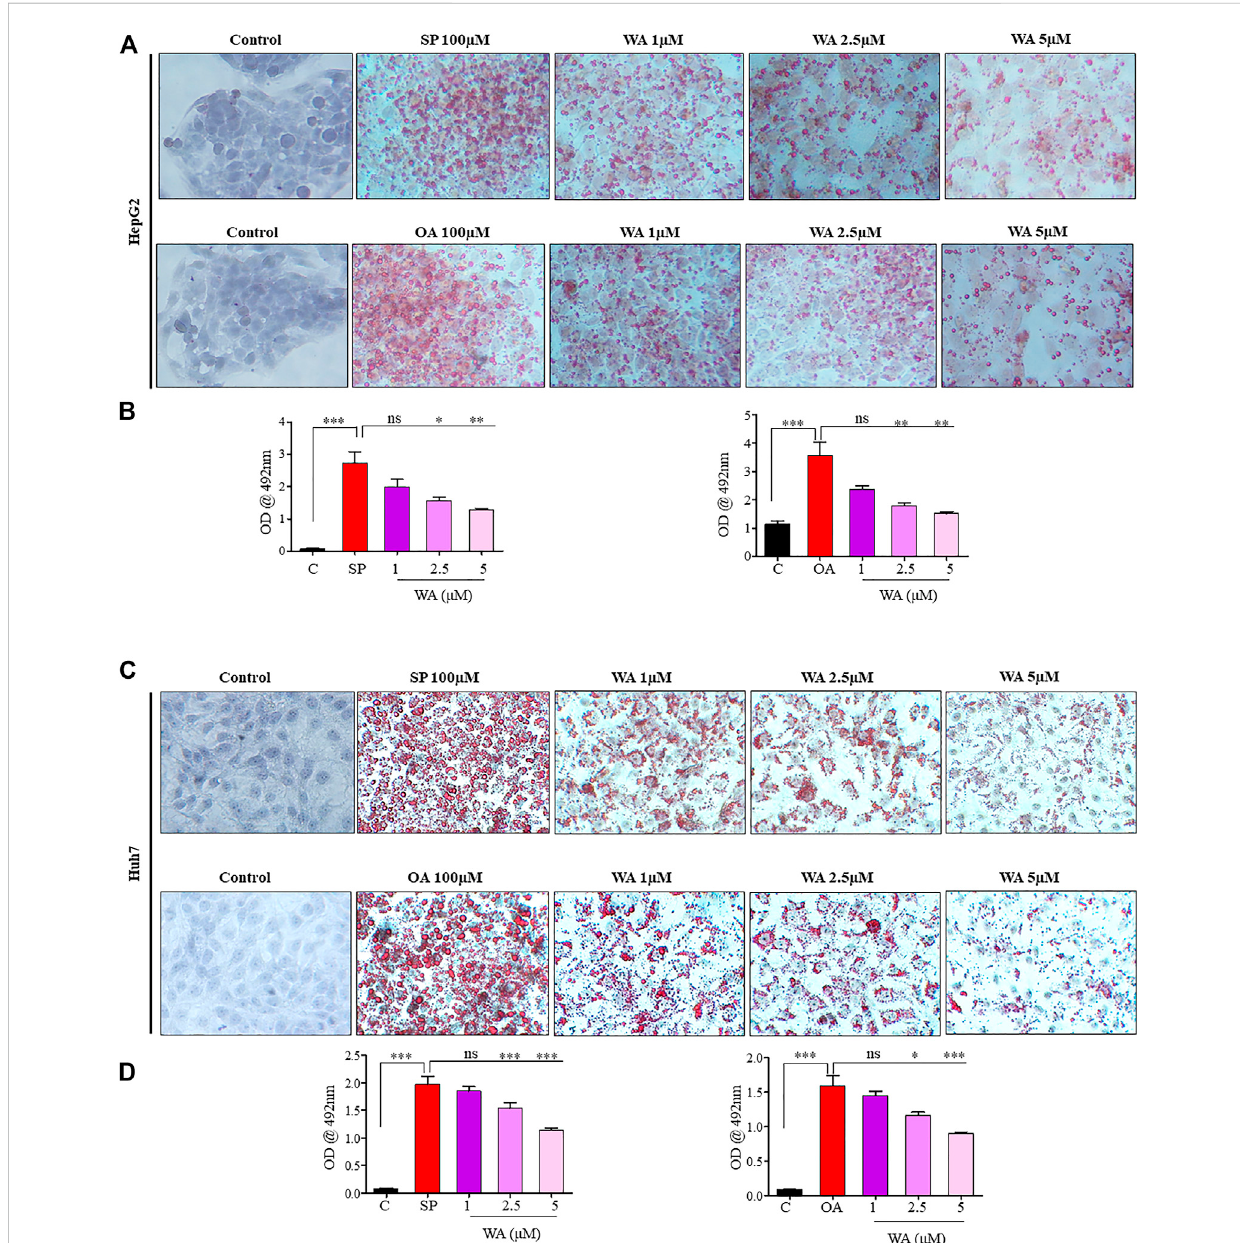
Withaferin A ameliorates steatosis and steatohepatitis in vitro . (A,C) Representative microphotographs of sodium palmitate and oleate-induced steatoticHepG2andHuh7cellstreatedwithwithaferinAinadose-dependentmanner.Thecellsweretreatedwiththetestmaterialsfor24 h,andimages were taken after ORO staining at 40X magni fi cation. A semi-quantitative analysis of lipid accumulation in the cells (B,D)